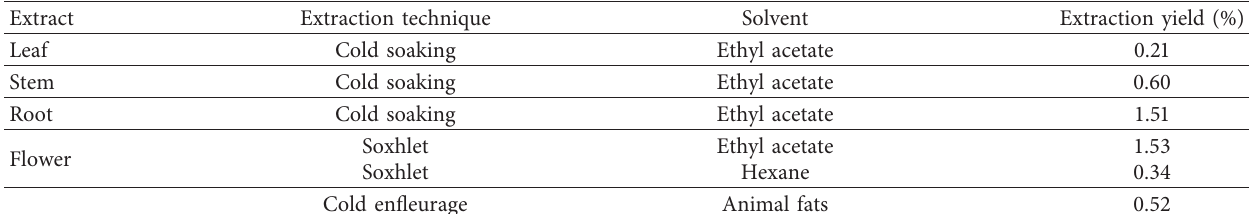
Table 1: Yield (in percentage) of the different extracts.